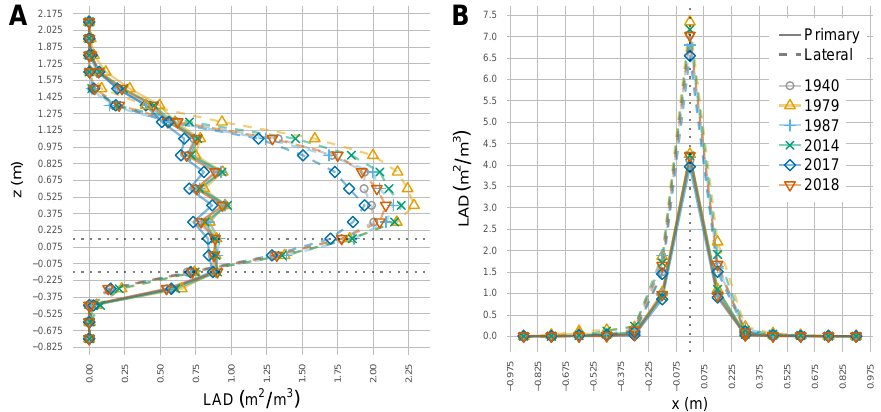
Figure 19. Leaf area density (LAD, m 2 m − 3 ) of primary and lateral leaves within the canopy section for: ( A ) horizontal ( z : height relative to centre of bunch zone; dotted: bunch zone); and ( B ) vertical (left and right of cane, dotted: cane-/ x -axis) layers with a thickness